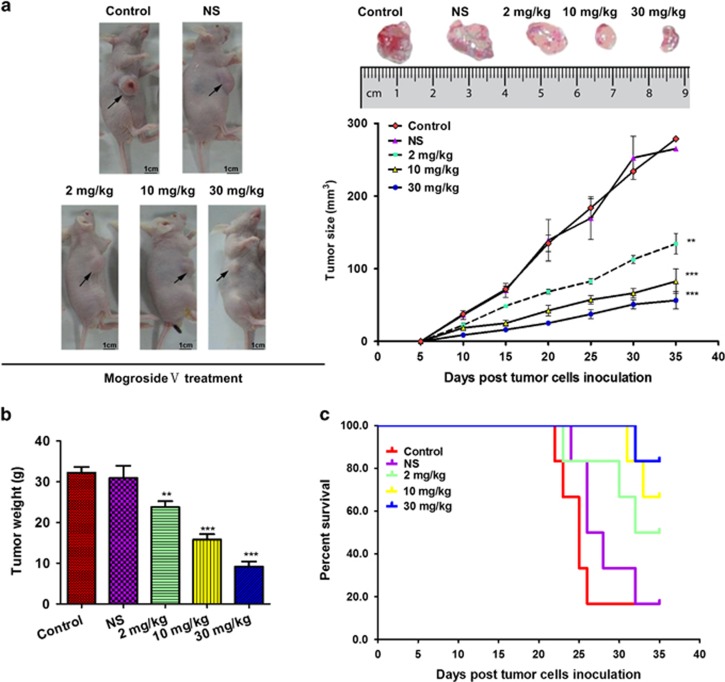
Mogroside V inhibits PANC-1 cell tumor growth in a mouse xenograft tumor model. Mice were implanted with PANC-1 cells and were randomly divided into five groups: a Control group, NC (normal saline) and three treatment groups receiving doses of 2, 10 or 30 mg/kg b.w. mogroside V three times a week. (a) The average volume of the tumor xenografts in the five groups, as measured with vernier calipers after the mice were killed and the tumor was anatomized 35 days post treatment. (b) The average weight of the tumor xenografts in the five groups. The tumor weight was significantly lower in the mogroside V treatment groups than that in the control and NC groups. For statistical analysis, mogroside V-treated mice were compared with vehicle control mice using Student's t-tests; **P<0.01 and ***P<0.001 versus the control values. (c) Kaplan–Meier survival analysis showed that mogroside V treatment was significantly correlated with overall survival (P<0.01, using log-rank test, P<0.05 was considered significant).